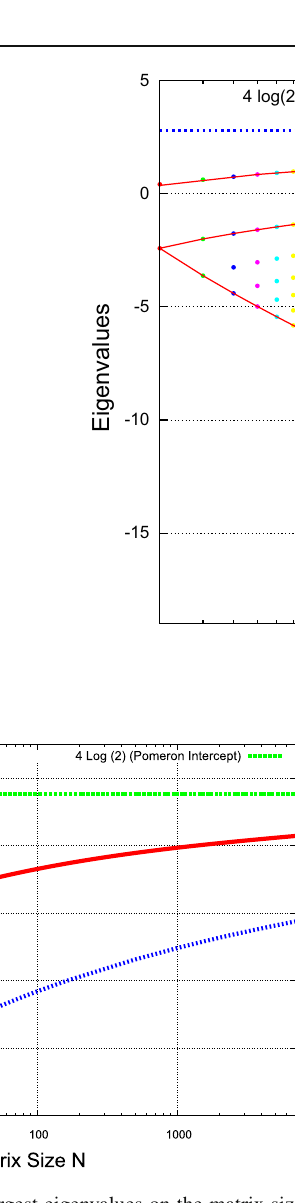
Fig. 8 Dependence of the two largest eigenvalues on the matrix size N